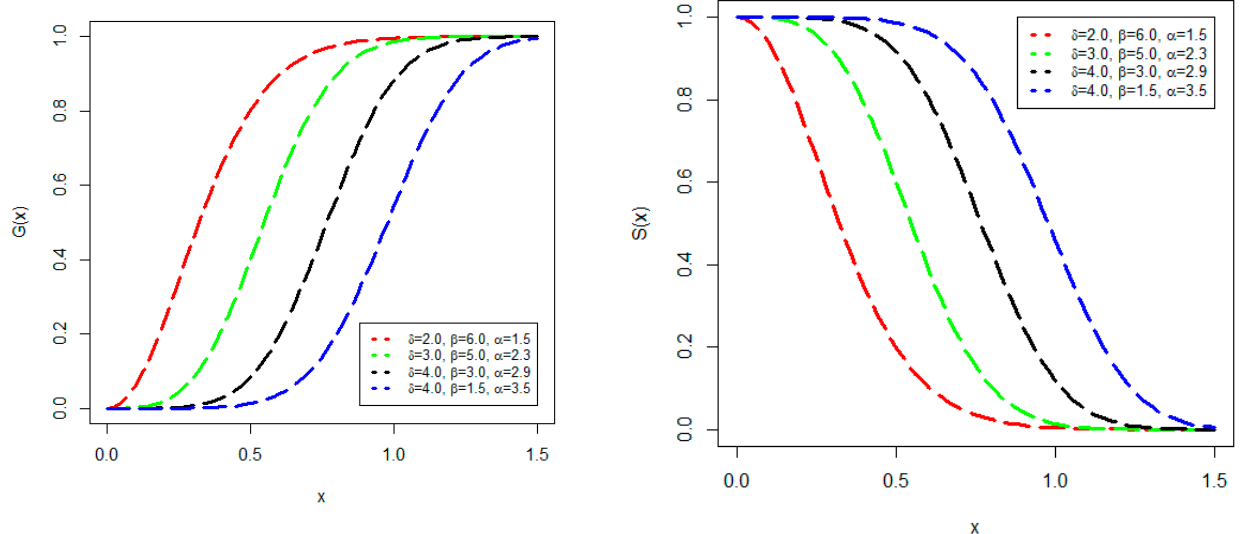
( ) ( ) ; , G x δ Θ CDF ( left ) and the ; , S x δ Θ SF ( right ) of the NGLog– Figure 1. Plots of the G ( x ; δ , Θ ) CDF ( left ) and the S ( x ; δ , Θ ) SF ( right ) of the NGLog–Weib model. Figure 1. Plots of the Weib model. Corresponding to G ( x ; δ , Θ ) in Equation (13), the PDF, g ( x ; δ , Θ ) , is